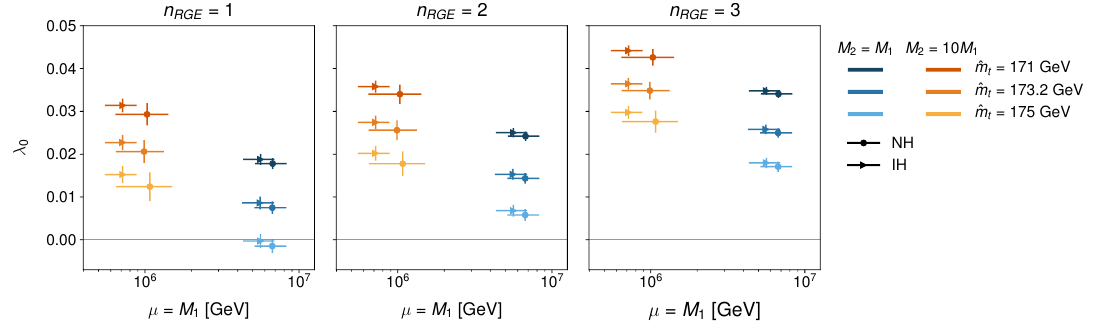
Figure 6 . Regions of the ( M 1 ; (cid:21) 0 ) parameter space in which the neutrino option can be realized, for di(cid:11)erent choices of: the SM RGE order (panels from left to right), the top mass ^ m t (colors from lighter to darker), the neutrino mass ordering (dots vs triangles) and x = M 2 =M 1 (blue for x = 1, orange for x =